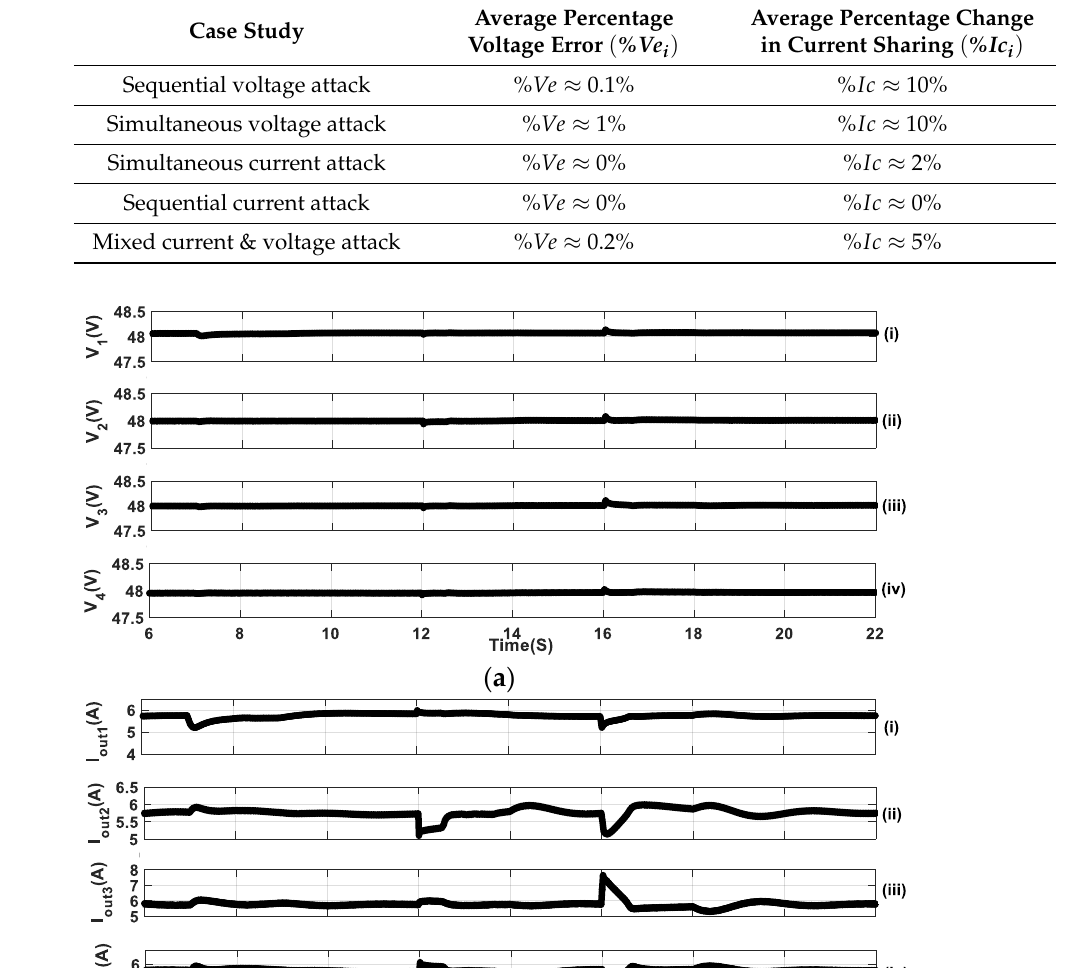
Table 9. Performance metrics for all case studies during cyber-attacks.